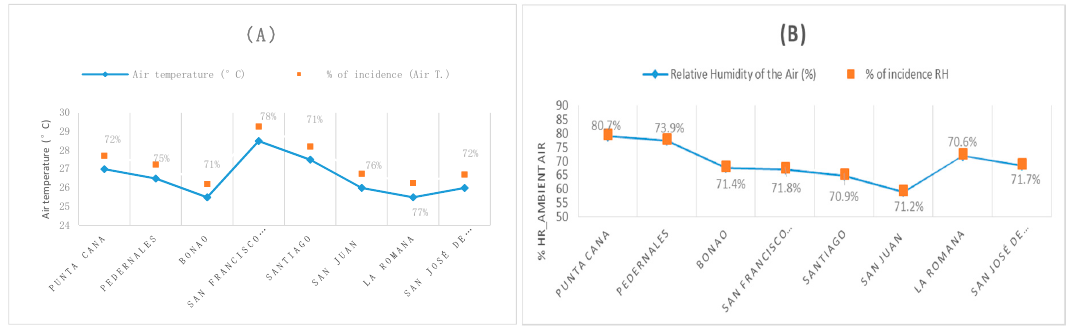
Figure 5. % of ( A ) air temperature and ( B ) relative humidity, significant in each province.